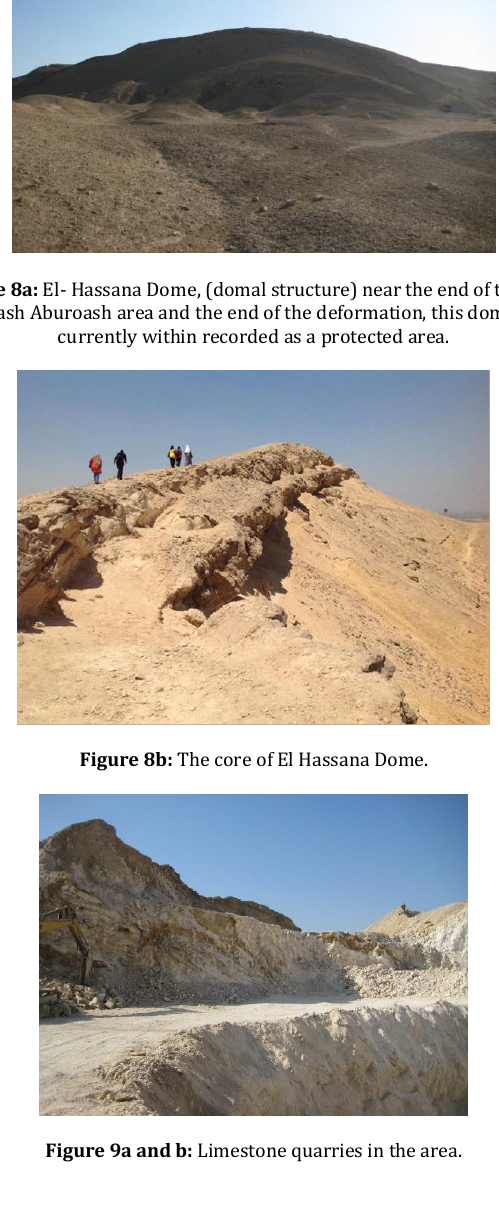
Figure 6: Tilted chalk limestone beds (Eocene) as they occur in Abu Roash., The human impact is clear in this photo with garbage dumped